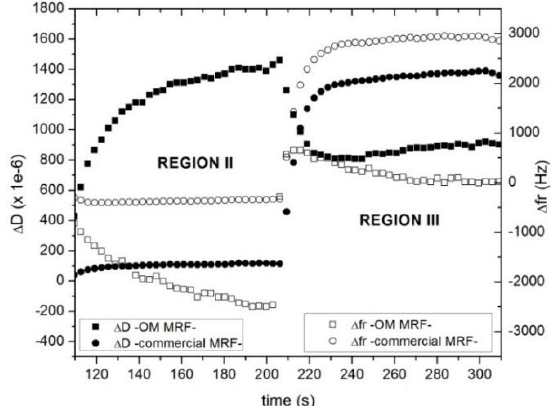
Figure 8. Dissipation (solid) and resonance frequency shift (open) of OM MRF 5% (squares) and commercial MRF 32% (circles) as function of time at 8 MHz. In the first step (region II) the shear rate is set to zero, letting the structure evolves to equilibrium after the pre-shear rate. In the second step (region III), a 15-kA/m magnetic field is applied perpendicularly to the rheometer plates.